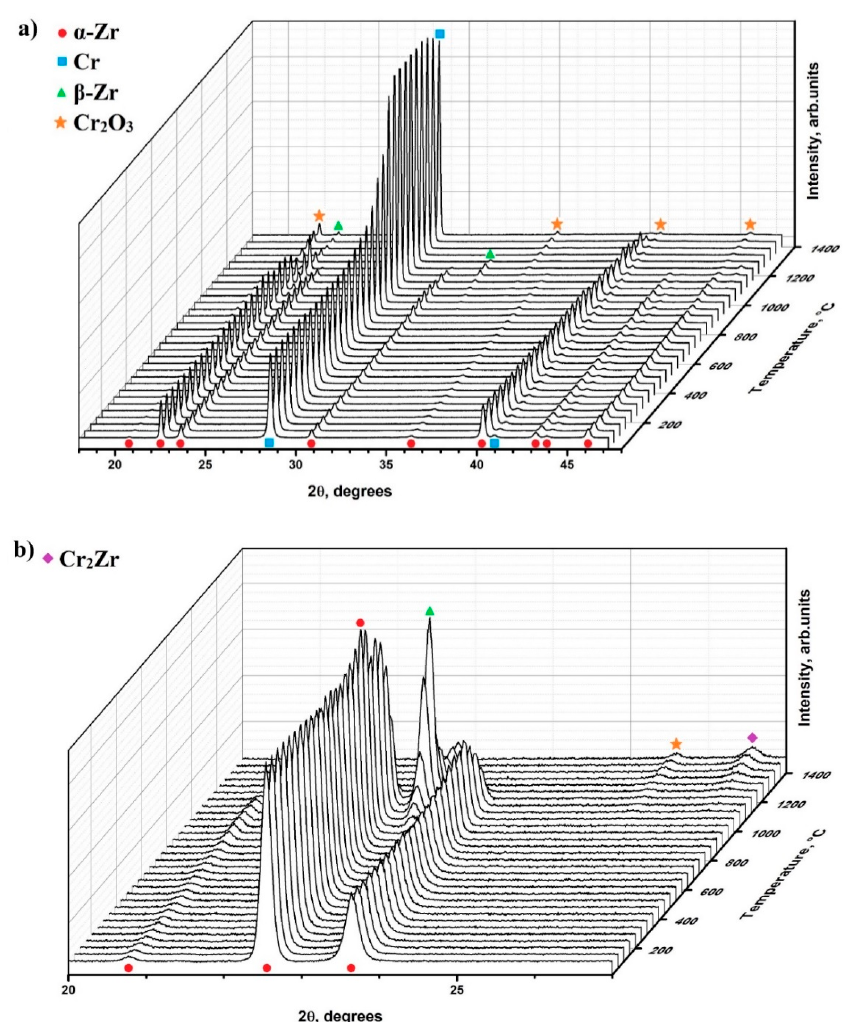
Figure 9. Phase transitions in E110 alloy with the Cr coating under linear heating in the temperature range of 25–1400 °C: ( a ) 2 θ range of 19°–47°; ( b ) zoom area of 20°–27°.